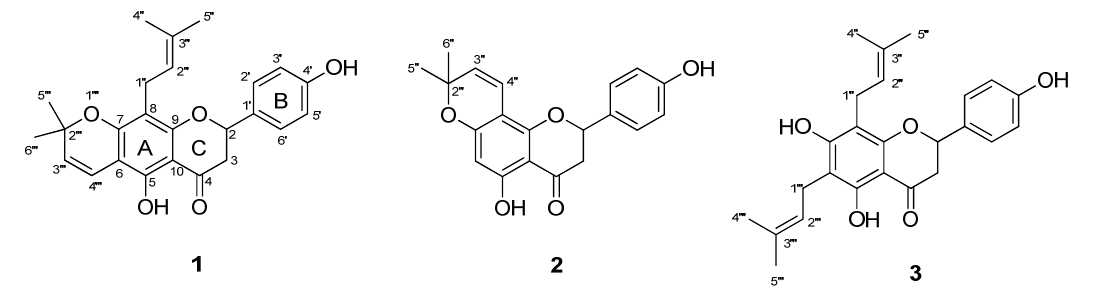
Figure 2. Chemical structures of flavanones isolated from E. crista-galli.